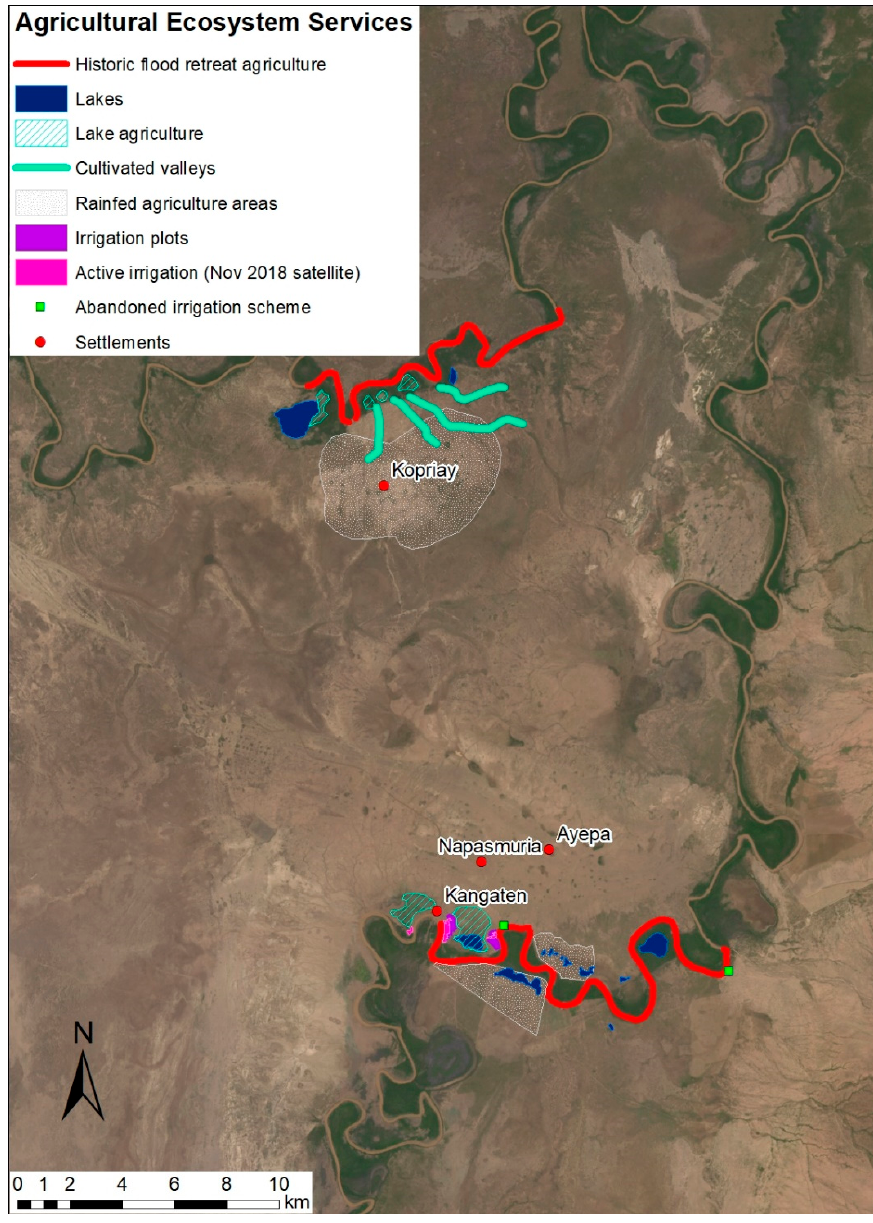
Figure 4. Example digitized participatory map for arable agriculture ecosystem services (ES), synthesizing data from all focus groups. Maps for grazing, natural products and cultural ES are included in the supplementary materials (Figures S1–S3).